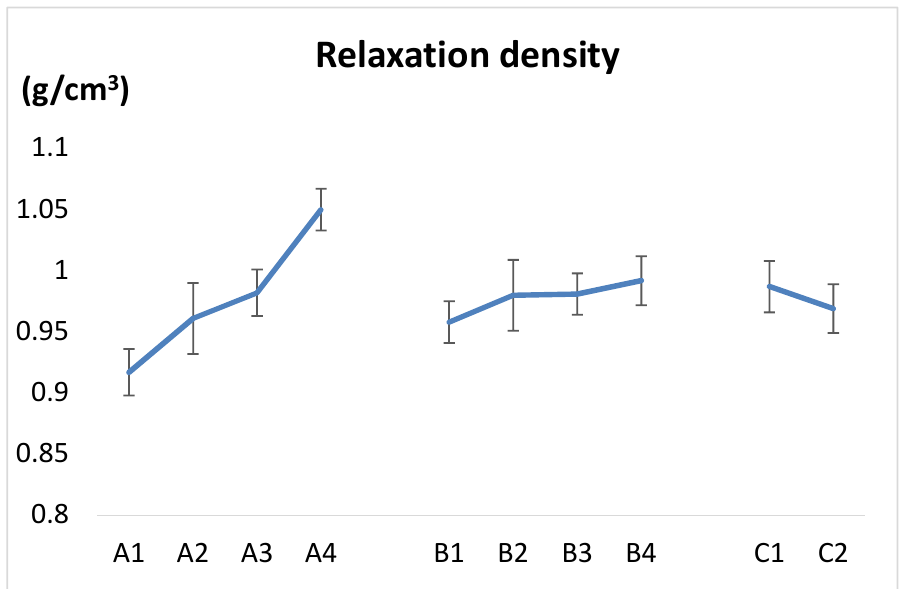
Figure 5. Factors and levels—relaxation density; A—compaction pressure (A1–A4: 75, 100, 124 and 149MPa); B—binder addition ratio (B1–B4: 0%, 3%, 6% and 9%); C—binder addition method(C1–C2: spraying and stirring).